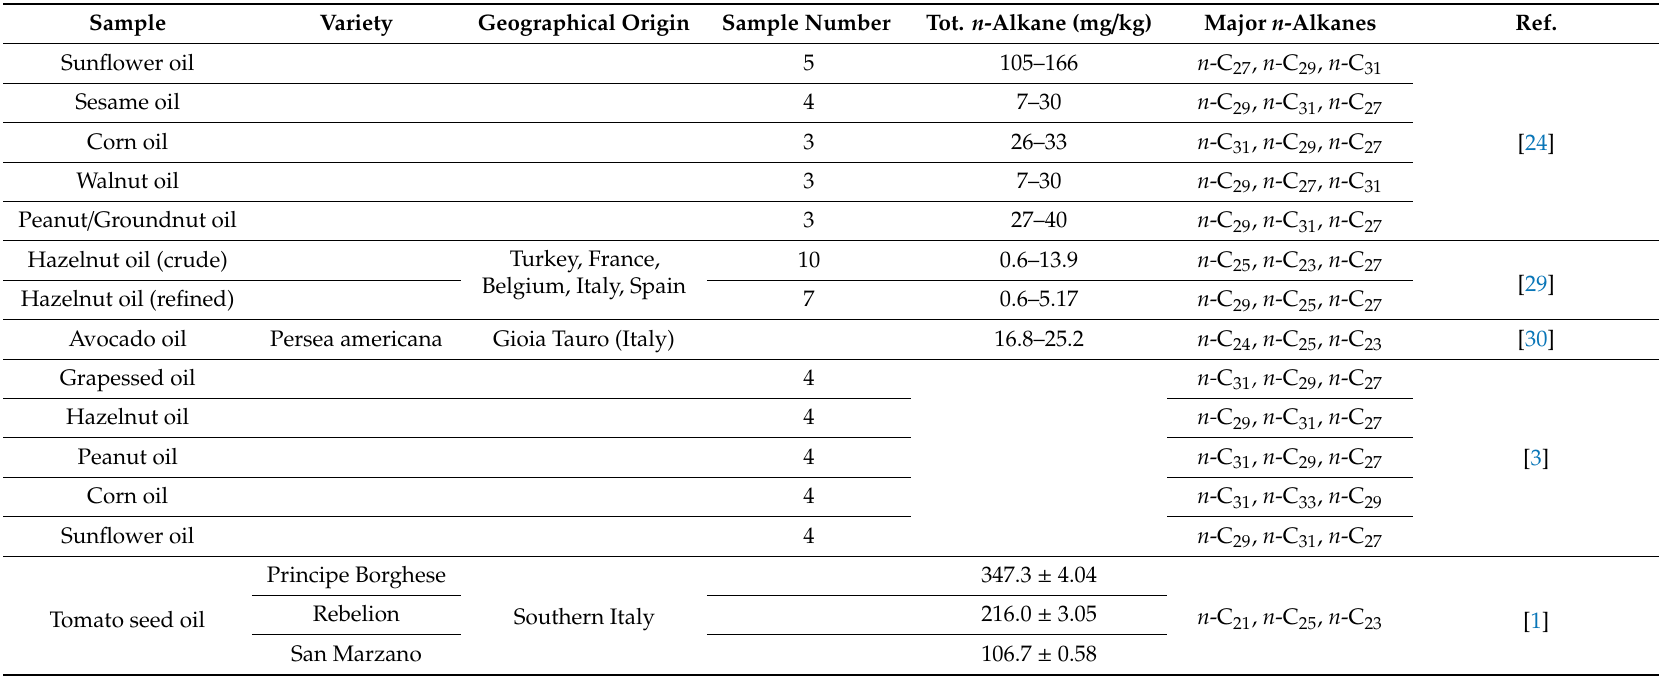
Table 2. Summary of n -alkane presence in various vegetable